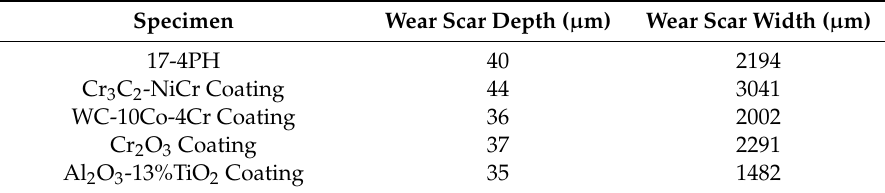
Table 4. Wear track results of the lower specimens (100 N, 300 r /